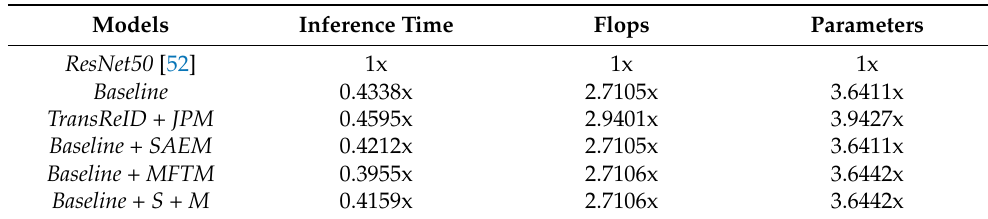
Table 6. Comparison of inferential costs on a different model. Baseline + S + M denotes baseline, and both modules are used together.